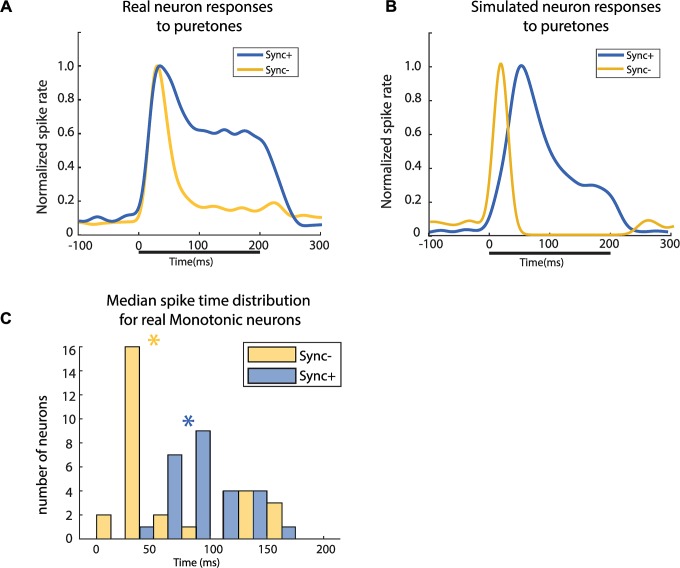
Pure tone responses.Normalized responses to pure tones in real (A; Sync +, n = 25. Sync-, n = 26) and simulated neurons (B; 30 simulated neurons). Normalized spike rate was obtained by dividing the population average response to the average peak response during stimulus presentation. (C.) Distribution of median spike times during stimuli presentation of all Sync+ neurons (green asterisk: median of distribution = 89ms) and Sync- neurons (yellow asterisk: median of distribution = 44ms). The two distributions were significantly different (Wilcoxon rank sum test, P < 0.001).